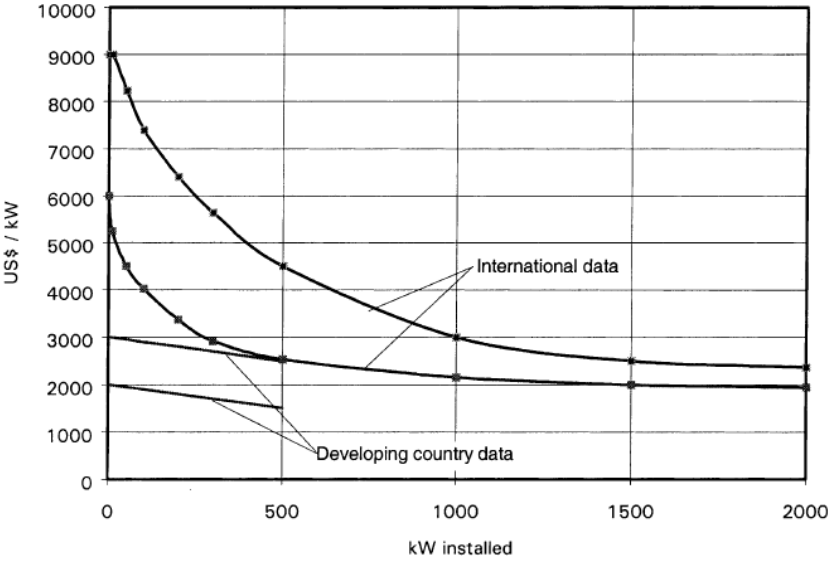
Figure 38. Economies of scale for small hydropower projects [164]. © 2002 Elsevier, reproduced with